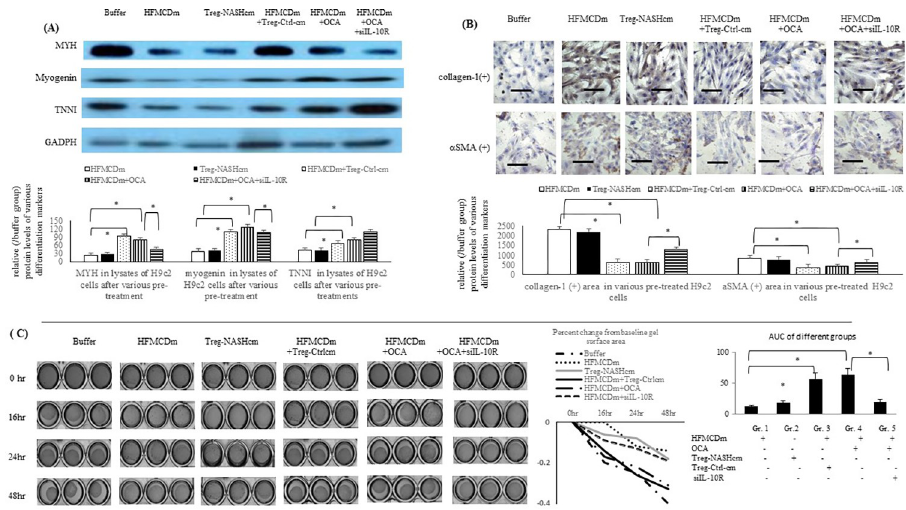
Fig 6. Acute OCA incubation normalised the HFMCDm and Treg-NASHcm suppressed differentiation and contraction of H9c2 cells. ( A ) Expression of the differentiation markers [cardiac myosin heavy chain (MYH), myogenin, TNNI] levels (/Buffer group) in supernatant of H9c2 cells. ( B ) The collagen-1 and α SMA positive among H9c2 cells. ( C ) Collagen gel contraction assay for evaluating the function of cardiomyocyte after various pretreatment. Scale bar = 20 μ m. CD4+CD25+ Treg-NASH+OCA [supernatant of Treg cells from NASH mice as condition medium (cm) plus acute OCA incubation].